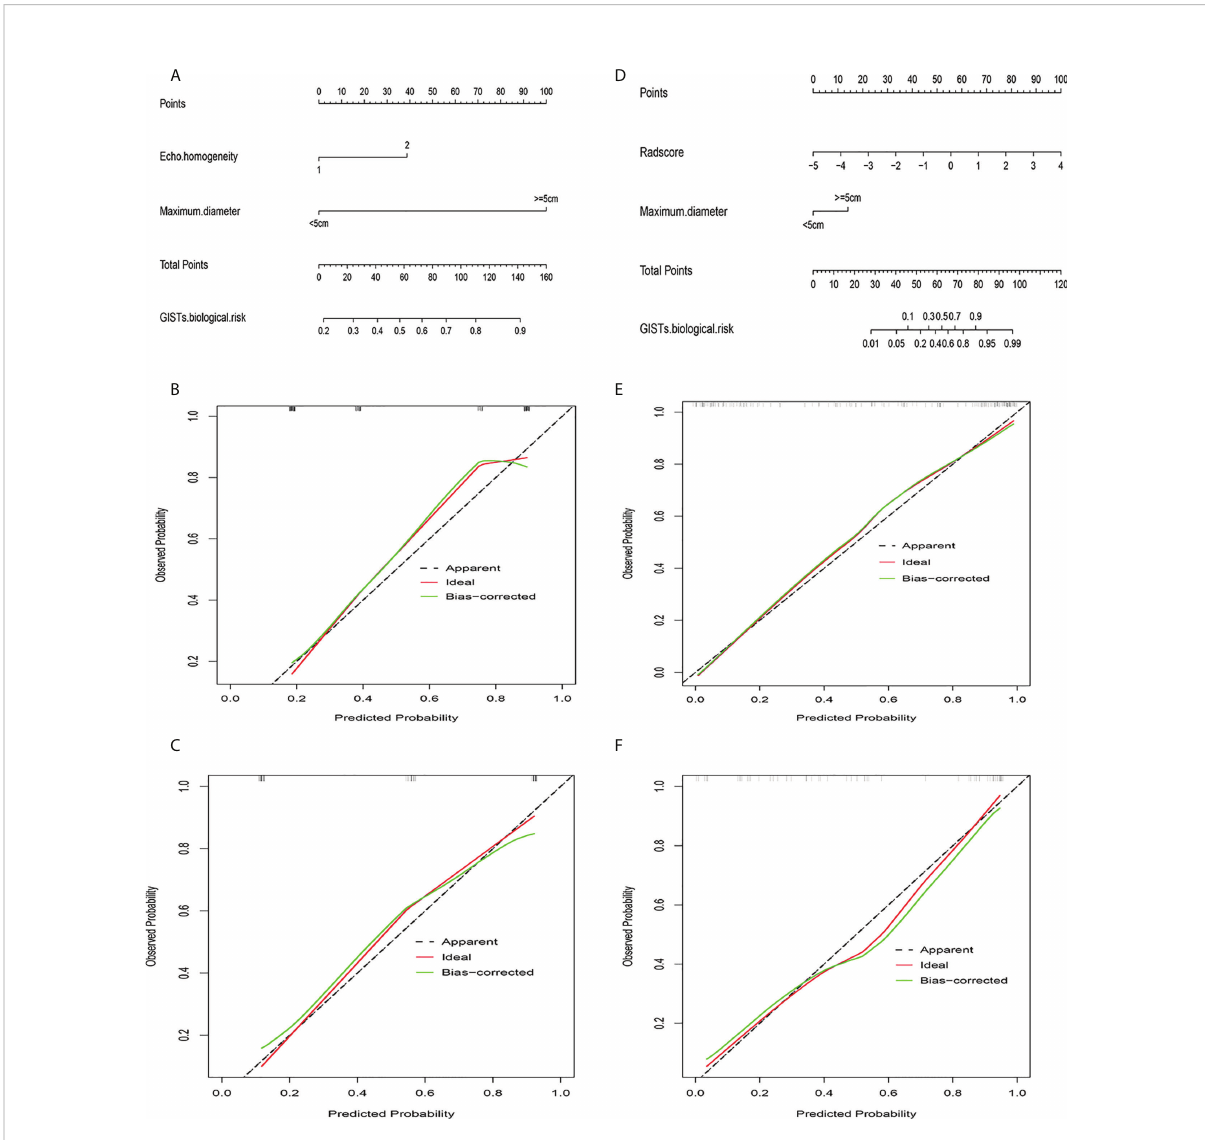
FIGURE 7 Clinical ultrasound nomogram and radiomics nomogram. (A) Nomogram of clinical ultrasound model. (B) Calibration curve of clinical ultrasound nomogram in training cohort. (C) Calibration curve of clinical ultrasound nomogram in validation cohort. (D) Nomogram of radiomics model. (E) Calibration curve of radiomics nomogram in training cohort. (F) Calibration curve of radiomics nomogram in validation